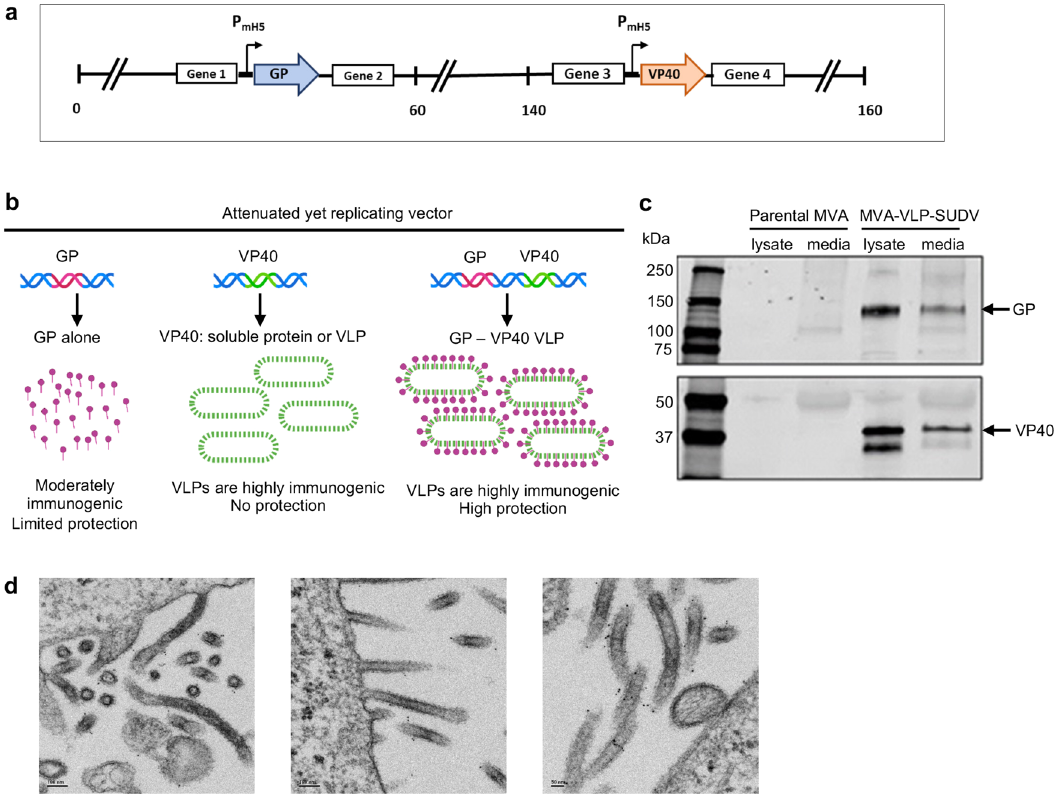
Fig. 1 Design and characterization of MVA-VLP-SUDV vaccine. a MVA-VLP-SUDV construction. Sequences encoding SUDV GP and EBOV VP40 were inserted into the MVA backbone at two distinct sites between essential genes under direction of the modi fi ed H5 promoter. b Schematic representation of the mechanisms resulting in high immunogenicity of the MVA-VLP-SUDV construct. c MVA-VLP-SUDV antigen expression. Lysates and supernatant were collected from MVA-VLP-SUDV or parental MVA infected DF1 cells, subjected to Western blotting and probed with antibodies speci fi c for SUDV GP (top) or VP40 (bottom). Expression of SUDV GP and EBOV VP40 was visualized in both the lysate and supernatant of recombinant vaccine infected cells. d VLP formation from MVA-VLP-SUDV infected cells. Thin layer sections of MVA- VLP-SUDV infected DF1 cell monolayers were visualized by TEM and reveal fi lamentous particle structure budding from the cell surface similar to native SUDV. Immunogold staining is speci fi c for SUDV GP. Representative micrographs are shown with scale bars depicted on the bottom left corner. The scale bar sizes for the three microphotographs, from left to right are: 100 nm, 100 nm, 50